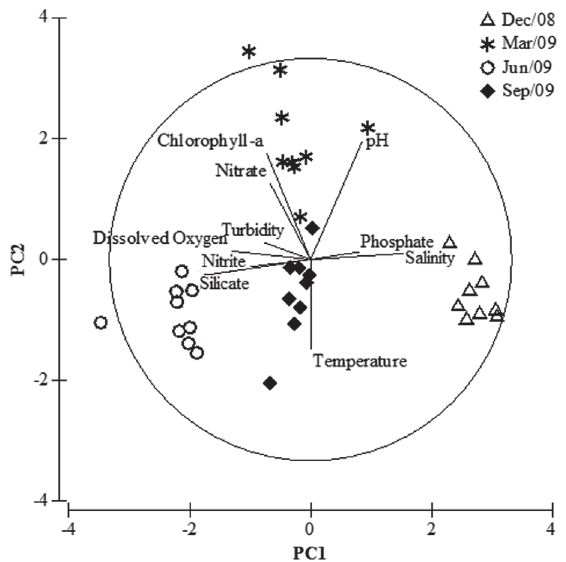
Figure 9 - Principal Component Analysis (PCA) of the en- vironmental variables studied at Ajuruteua beach, Bragança,